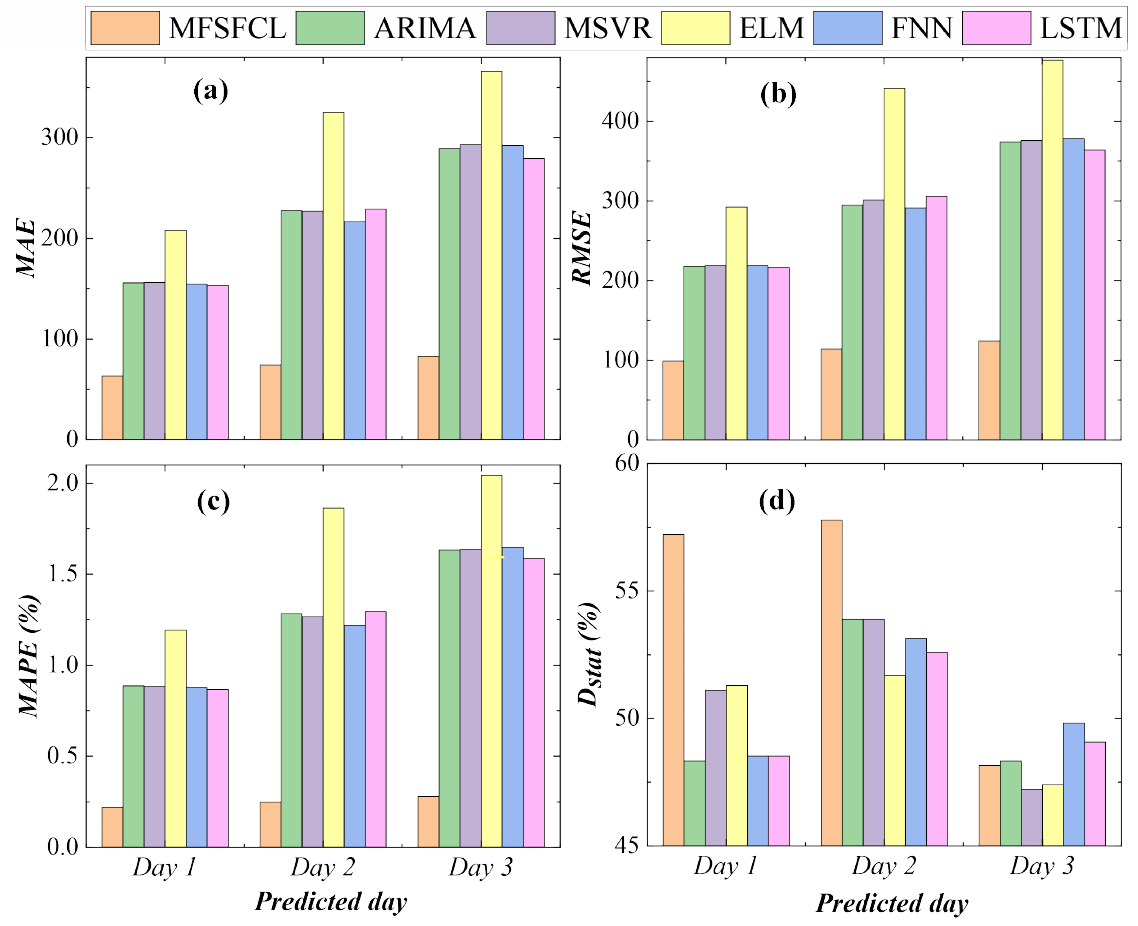
Figure 6. The comparison of different forecasting models for different days. ( a – d ) are the results for MAE, RMSE, MAPE, and D stat , respectively. Table 3. Forecasting performance evaluation metrics of the proposed MFSFCL and other univariate